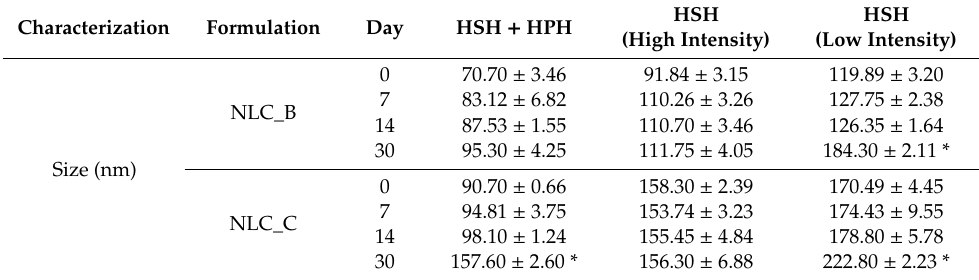
Table 1. Stability study of NLCs prepared by di ff erent methods—the combination of high-shear homogenization (HSH) and high-pressure homogenization (HPH), and high-shear homogenization (HSH) with di ff erent shear intensities—following storage at room temperature for 30